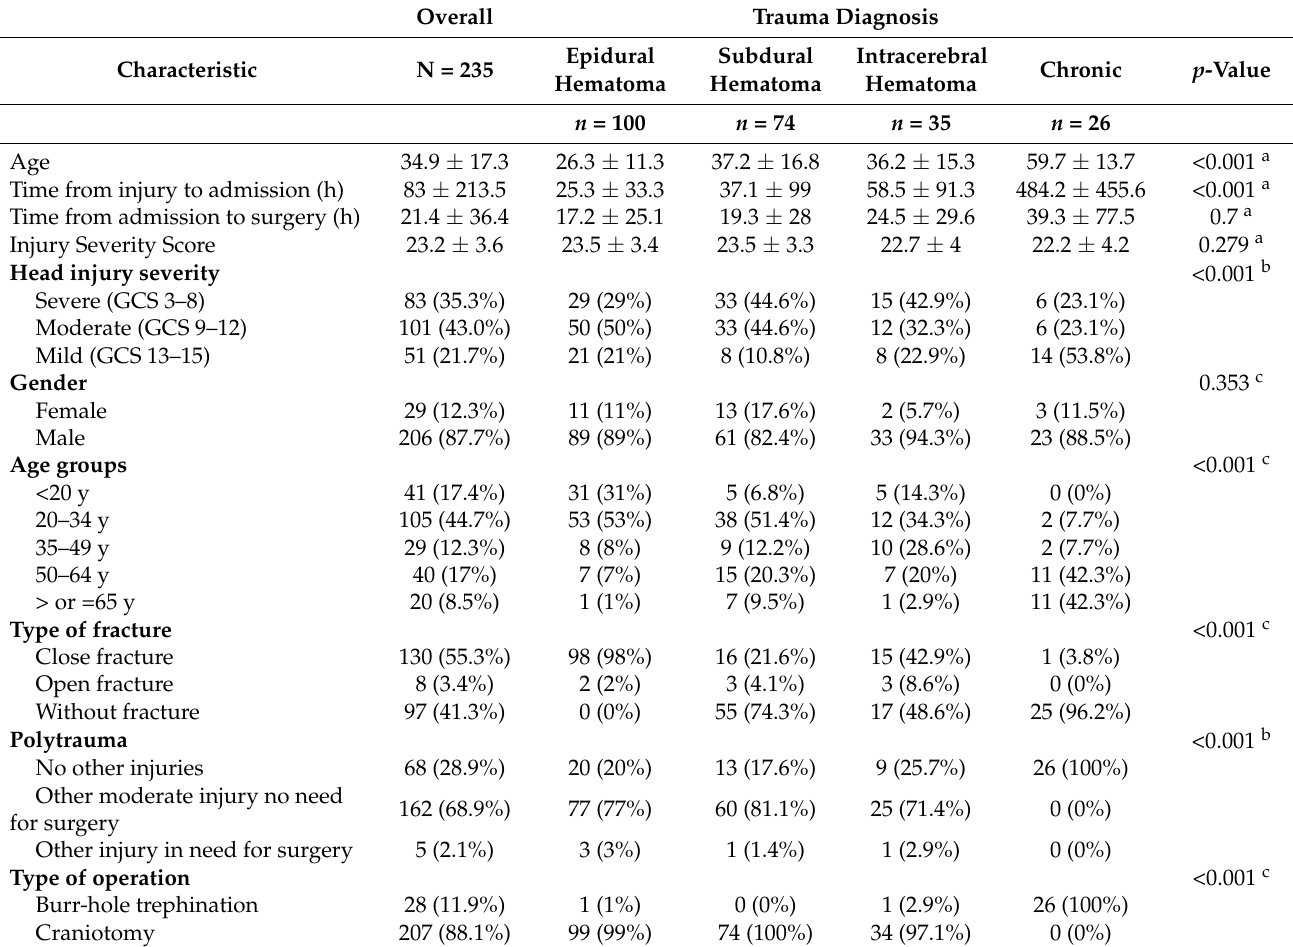
Table 2. Baseline characteristics of the study population grouped by trauma